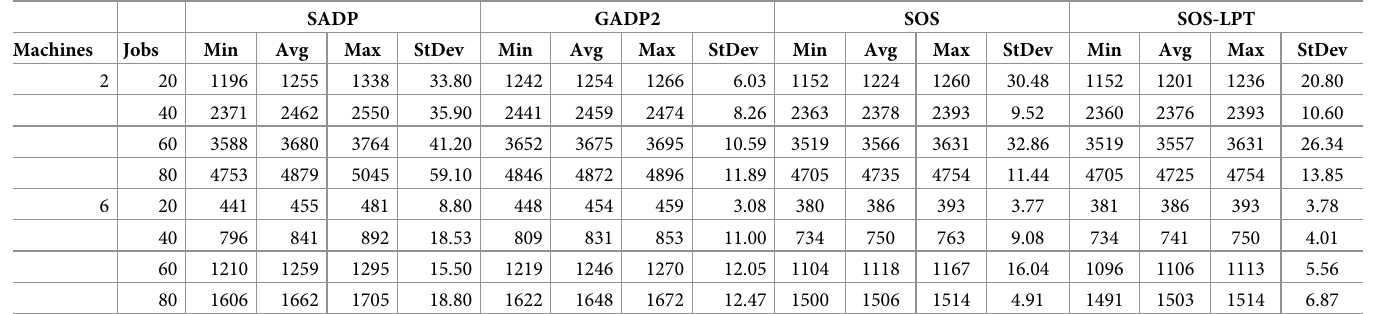
Table 6. Experimental results for 15 replicated runs of SADP, GADP2, SOS, and SOS-LPT algorithms.